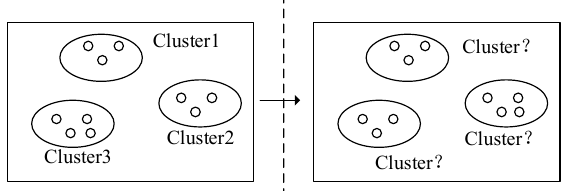
Figure 2. Dynamically clustering mapping problem.